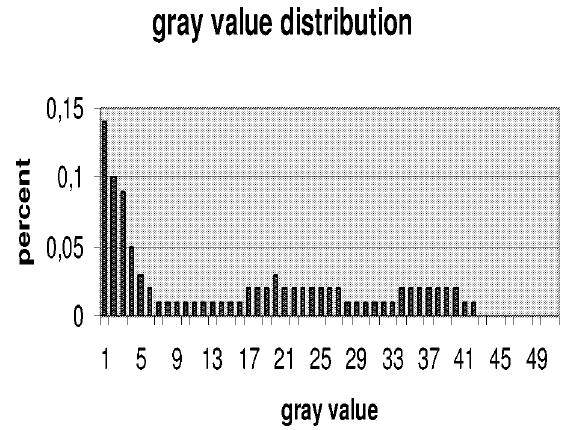
Fig. 2. Gray value distribution of a screening image at low magnifi- cation (obtained from Fig.